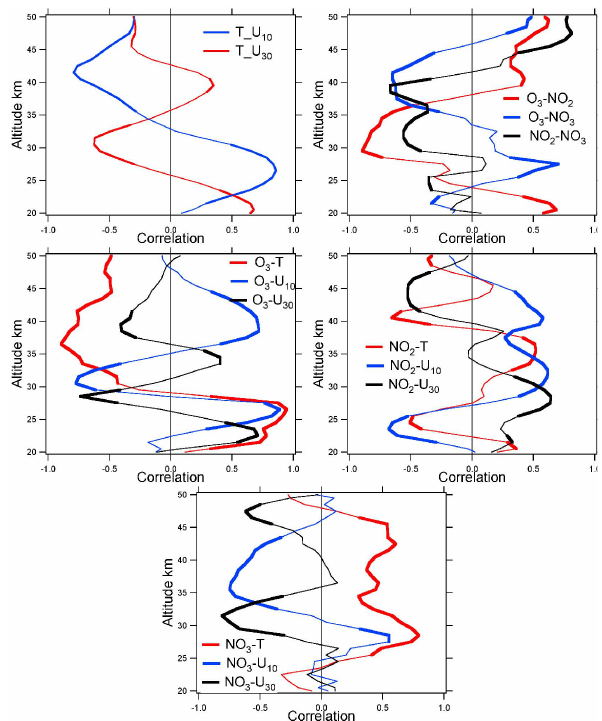
Fig. 7. Correlation coefficients between the deviation from their mean value for the full period at the given altitude of; Top left) Temperature ( T ) and equatorial wind at wind at 10hPa and 30hPa ( U 10 and U 30 ); Top right) O 3 , NO 2 and NO 3 mixing ratios (top left); Middle left) O 3 and T , U 10 and U 30 ; Middle right) NO2 and T , U 10 and U 30 ; Bottom) NO 3 and T , U 10 and U30. Values larger than ± 1 standard deviation uncertainty are represented with thick